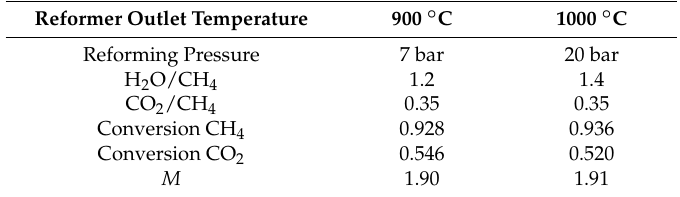
Table 8. Detailed results for the selected 900 ◦ C and 1000 ◦ C